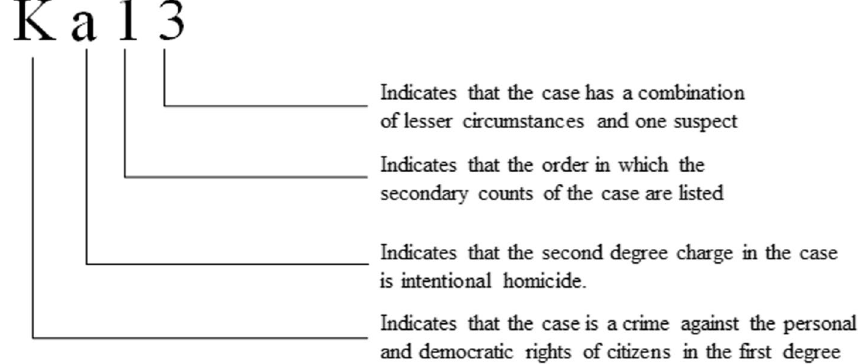
Fig. 3 Case grouping encoding design